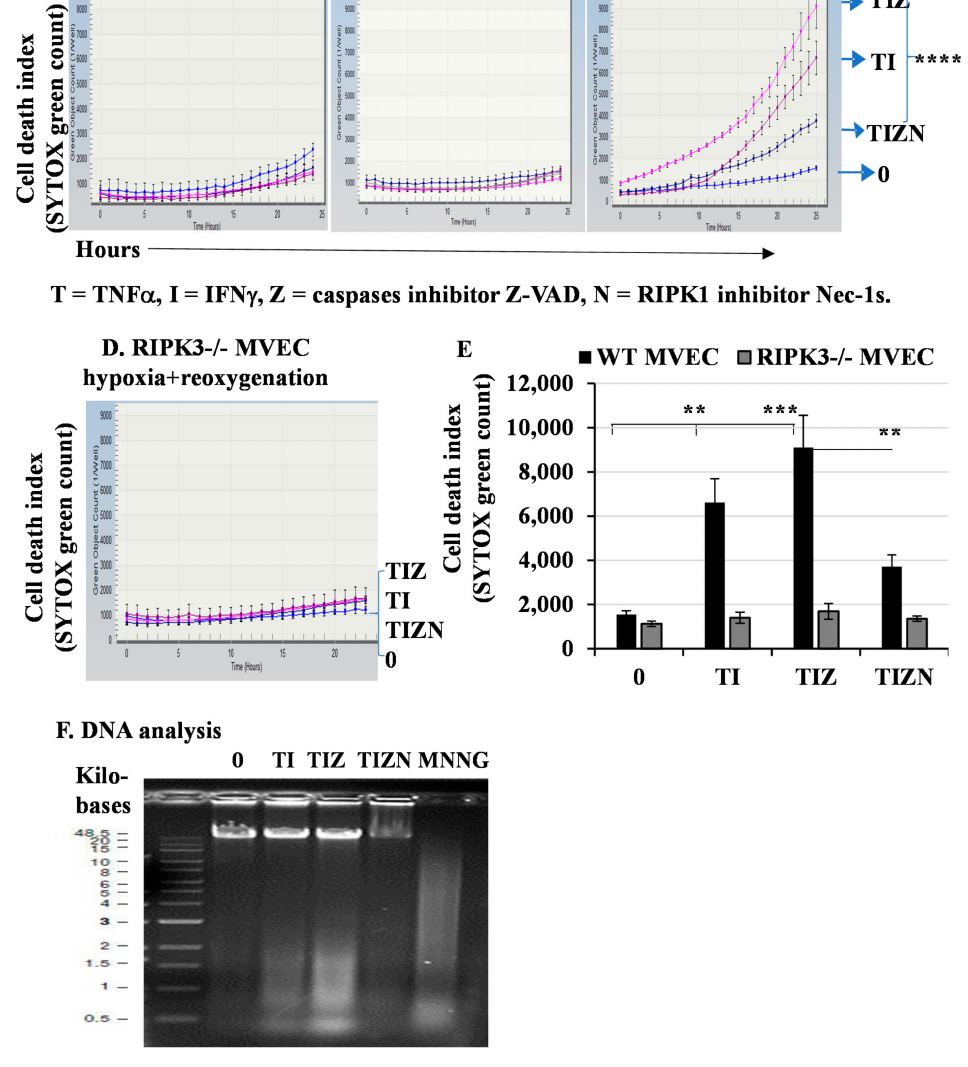
Figure 1. In vitro simulating IRI promotes necroptosis in MVECs. MVECs from wild-type (WT) B6 mice ( A – C ) or RIPK3 − / − mice ( D ) were seeded in a 96-well plate in triplicate. The cell culture plate was subjected to hypoxia for 24 h in anaerobic GENbags at 4 ◦ C followed by normal cell culture conditions at 37 ◦ C with 20% O 2 and 5% CO 2 . TNF α (T) at 50 ng/mL, IFN γ (I) at 50 ng/mL, z-VAD- fmk (Z) at 30 µ M and Nec-1s (N) at 10 µ M were added. SYTOX green at 100 nM was used as a nuclear counterstain to indicate dead cells. Cell death was detected and quantified in the IncuCyte Live Cell Image System. ( E ) Data at 24 h post-reoxygenation are shown as the mean ± standard deviation (SD) and represent at least 3 independent experiments. ** p ≤ 0.01, *** p ≤ 0.001 and **** p ≤ 0.0001, 1-way ANOVA and Tukey’s multiple comparisons test. ( F ) DNA degradation analysis. MVECs were seeded in 6-well plates and subjected to the in vitro IRI treatment as above. DNA was isolated, and an equal amount of DNA (2 µ g) was loaded onto 0.8% agarose gel for electrophoresis. MNNG (15 µ M) was used as a positive control to induce DNA degradation. The same experiment was repeated three times, and similar results were